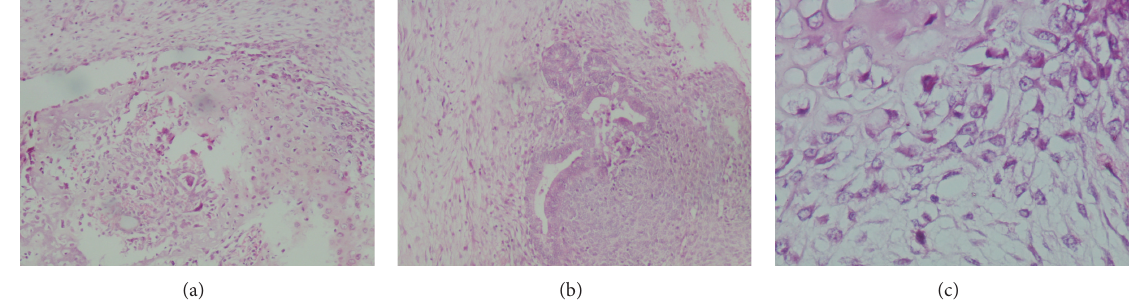
Figure 1: Microscopic findings of uterine mass specimen showing (a) cartilaginous foci (HES × 10), with (b) presence of glandular formations (HES × 20), and (c) ovoid cells involved in a fibrillar background (HES × 40).